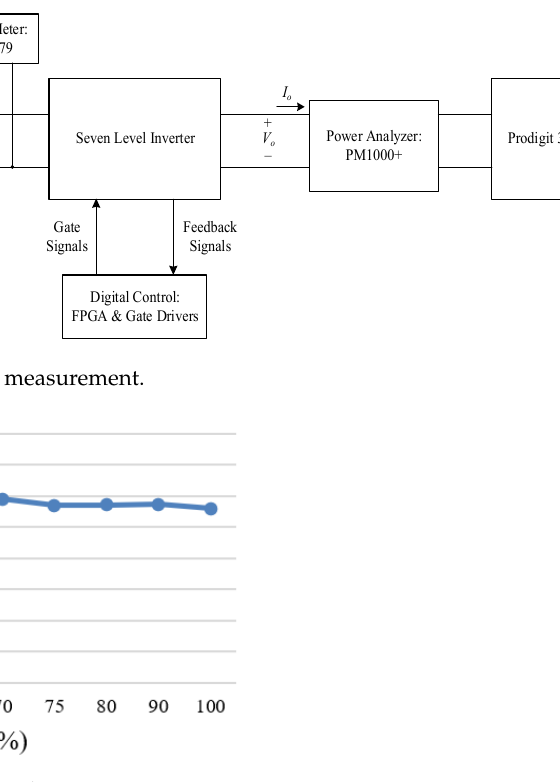
Figure 21. Curve of efficiency versus load.